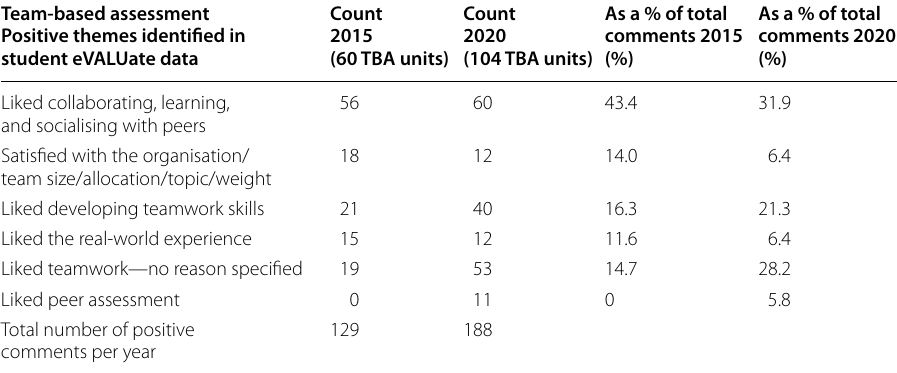
Table 8 The comparison of positive themes coded from voluntary student feedback in 2015 and 2020 and their associated percentage